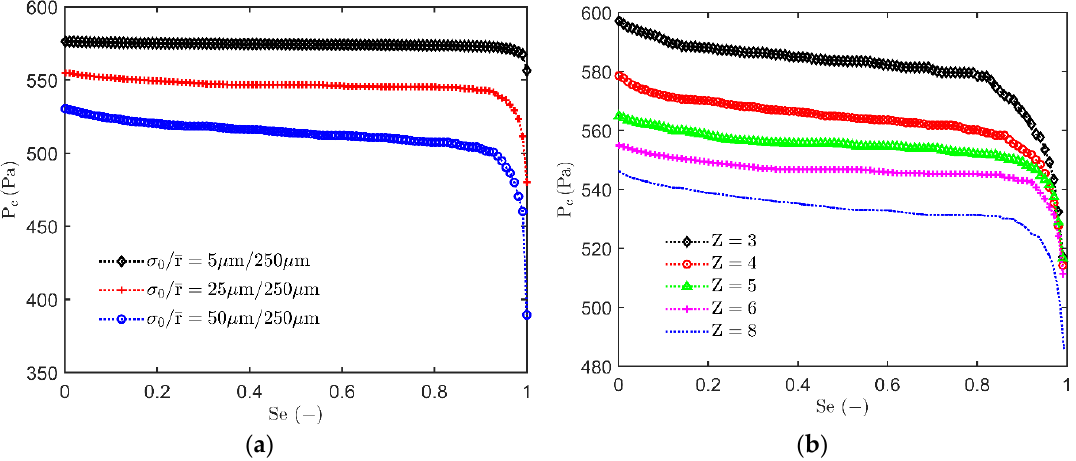
Figure 8. The capillary pressure profile with effective saturation, influenced by ( a ) the standard deviation at constant pore connectivity (Z = 6) and ( b ) the pore connectivity with σ 0 / r = 25 / 250 ( µ m). The simulation values are averaged over 40 realizations.